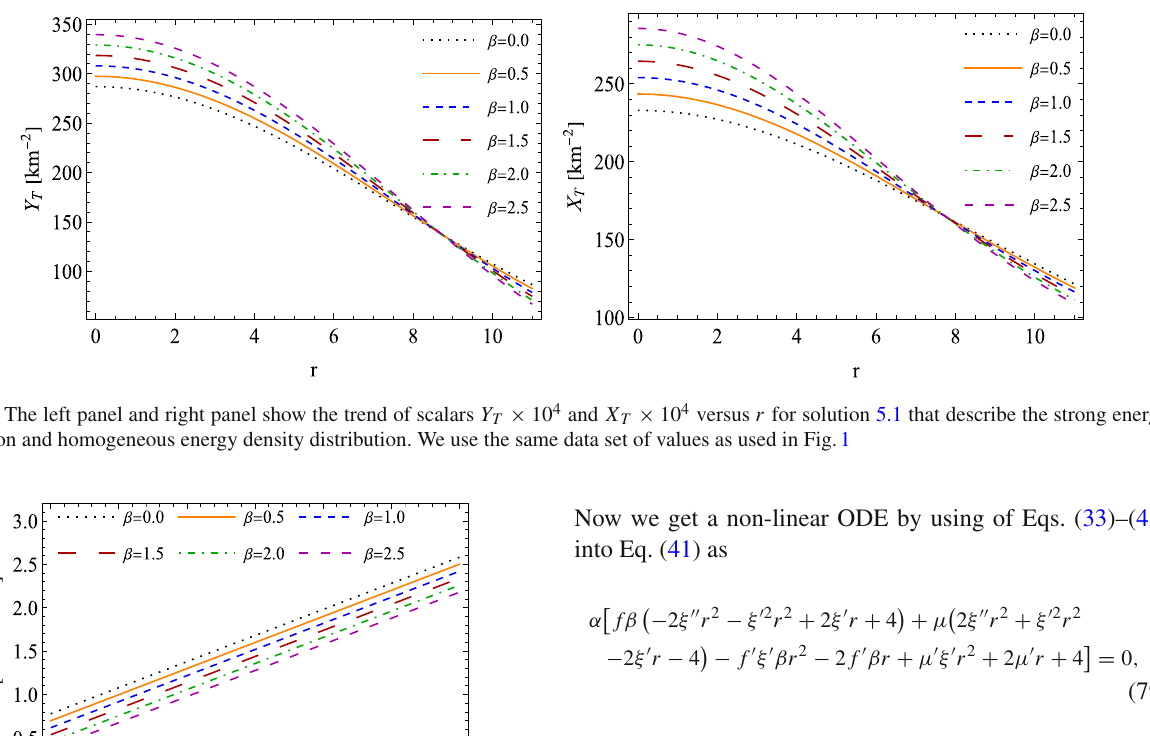
tion can be controlled by fixing of the decoupling parameter β = 0 and β = 1 that describe anisotropic system (36)–(39) and isotropic system (20)–(24), respectively. In this case, the